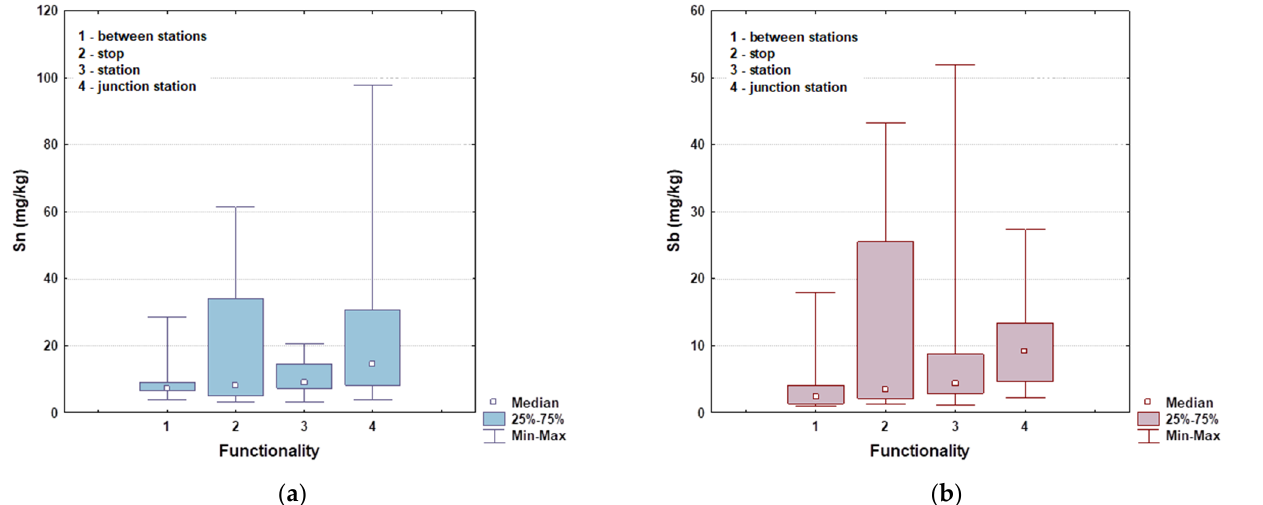
Figure 6. Dependence of concentration of Sn ( a ) and Sb ( b ) in soil and site functionality (boxplots were obtained by Kruskal–Wallis ANOVA followed by a pairwise comparison using Dunn’s method, with the significance level set at p < 0.05).